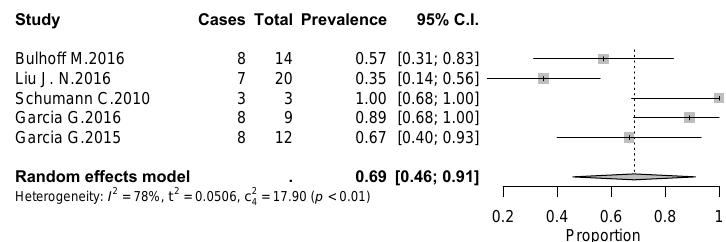
Figure 7. Forest plot chart of the rate of return to golf after shoulder arthroplasty with 95% confidence interval.